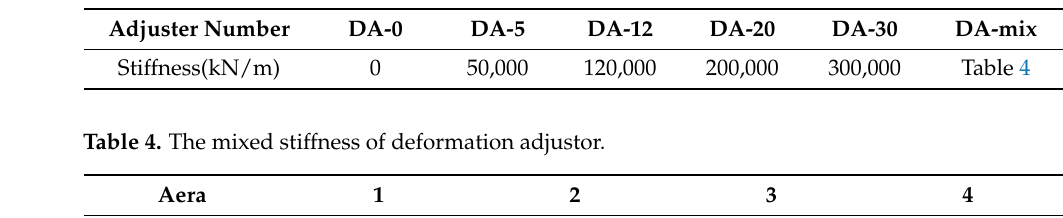
Table 3. Different stiffness of deformation adjustors.